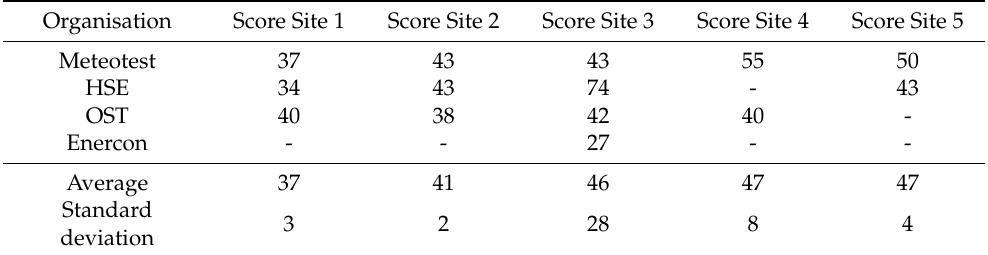
Table 1. Summary of the answers to the complex terrain questions for each